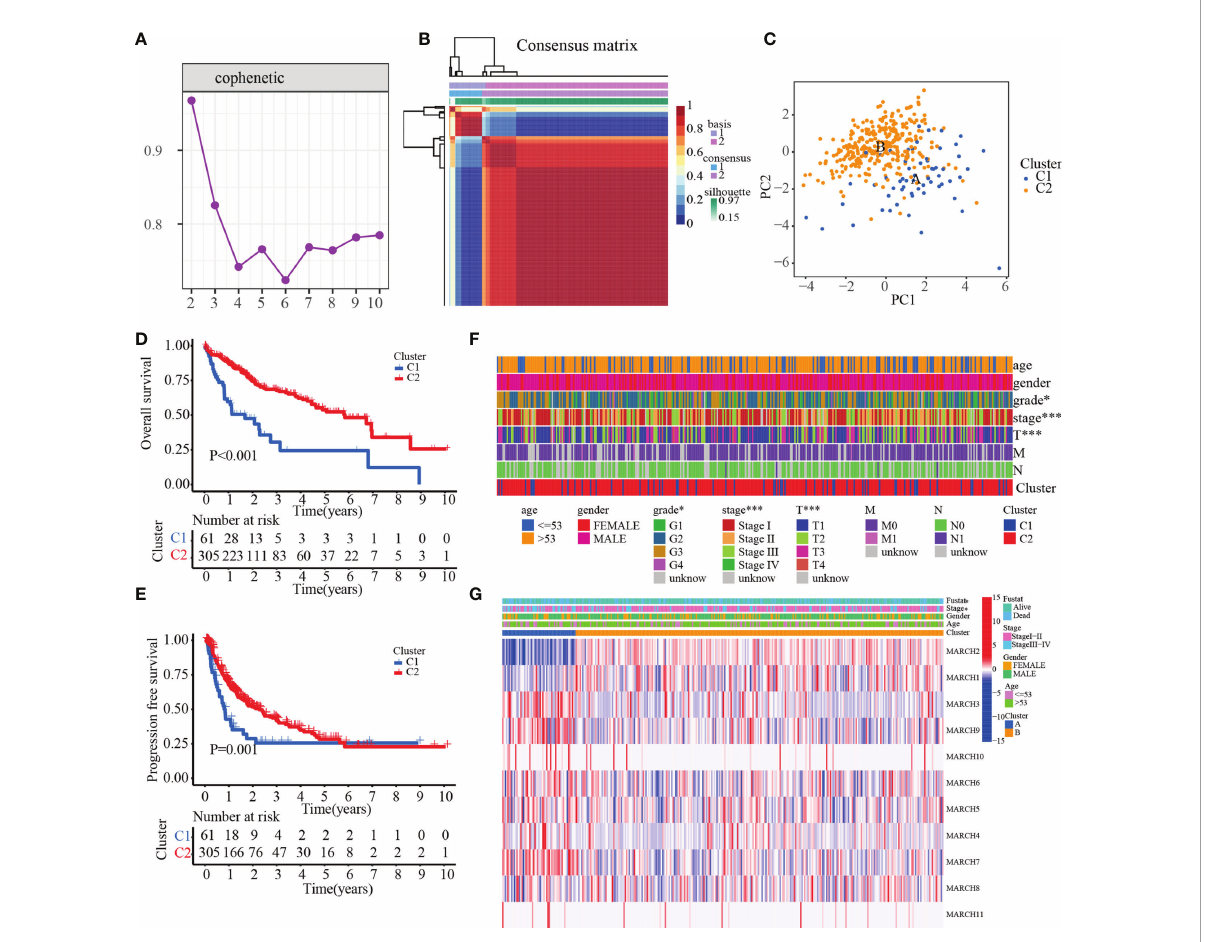
FIGURE 2 The prognostic value of C1 and C2. (A) Non-negative matrix factorization clustering of necroptosis-related patterns in the TCGA-HCC cohort. (B) Cophenetic coef fi cients. Expression pro fi le of prognosis-related MARCH ligase gene: (C) PCA and (D, E) Kaplan – Meier analysis of OS